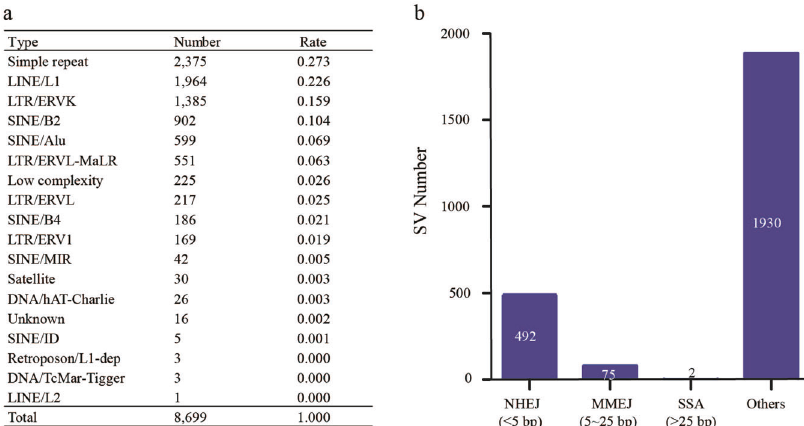
Fig. 4 Repetitive sequences and break repair by error-prone non-homologous repair pathways. a Repetitive sequence classi fi cation identi fi ed at SV breakpoints sites in Brca1 + / − mice. b Number of SV breakpoints repaired by error-prone non-homologous pathways of NHEJ, MMEJ, and SSA. It shows that NHEJ contributed the majority of the error-prone